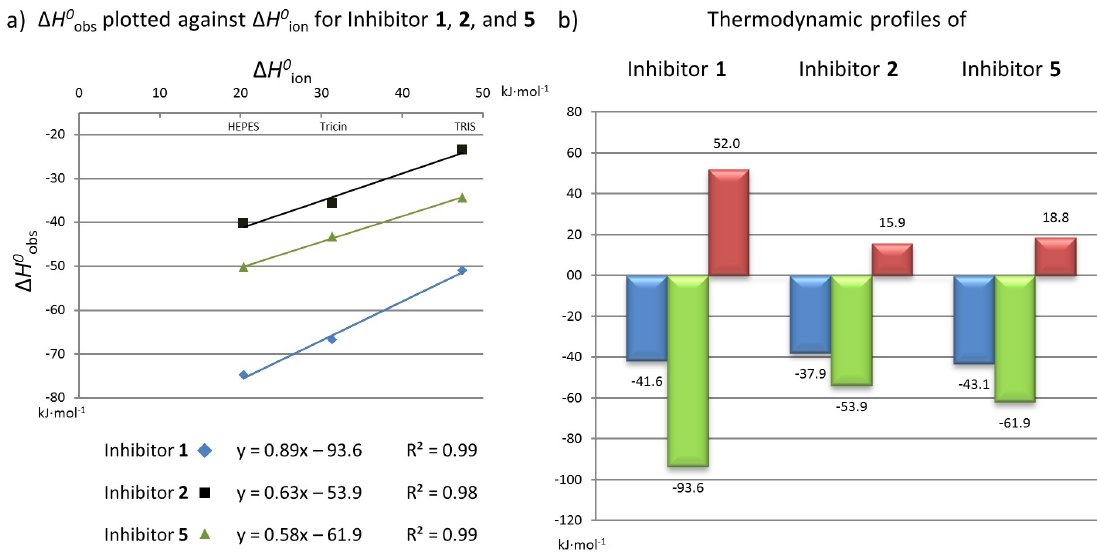
Fig 9. Plot of Δ H 0 obs against the buffer Δ H 0 ion and thermodynamic profiles. a) Measuredheat signal ( Δ H 0 obs ) is plotted againstthe ionizationenthalpy of appliedbuffers (HEPES, Tricin, TRIS) to extract the corrected enthalpyof binding( Δ H 0 bind ). Inhibitor 1 blue, 2 black, and 5 green. b) Thermodynamic parameters Δ G 0 (blue) and corrected values for Δ H 0 bind (green) and -T Δ S 0 (red) in kJ (cid:1) mol -1 .